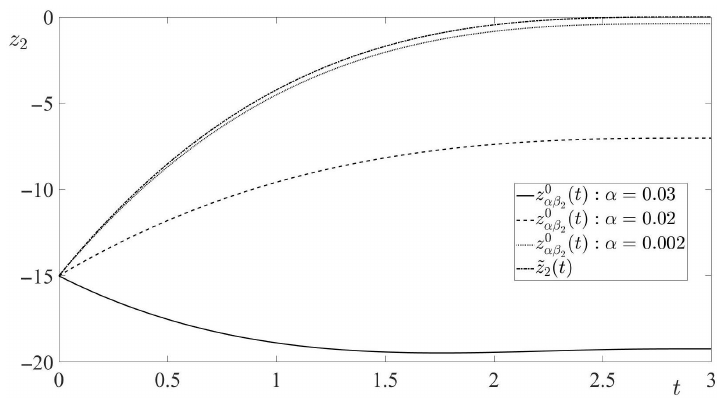
( t ) and limiting function ˜ z Figure 4. Trajectories z 0 αβ 2 The respective components of time realizations of the optimal strategies u 0 ( · ) , along with the components of the corresponding limiting functions ˜ u ( t ) and ˜ v ( t ) v 0 αβ